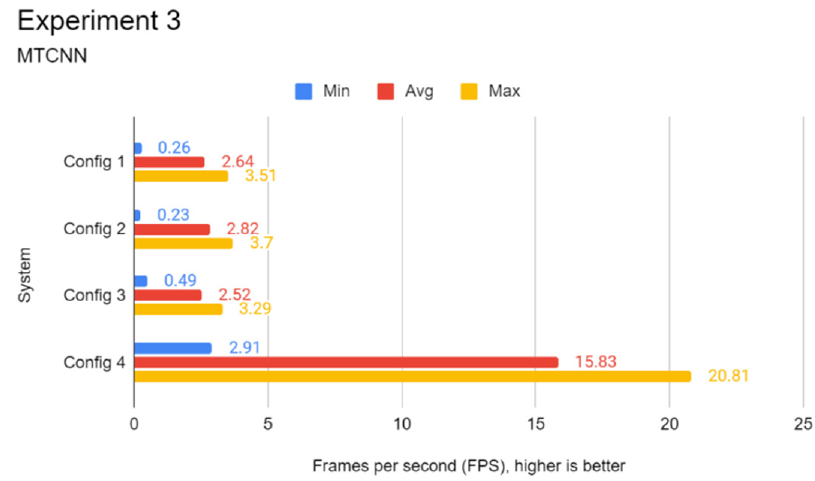
Figure A7. Bar chart execution time results for all systems running RetinaFace on WIDER FACE in Experiment 2. Configurations 2 and 3 are excluded due to Spark OOM error.